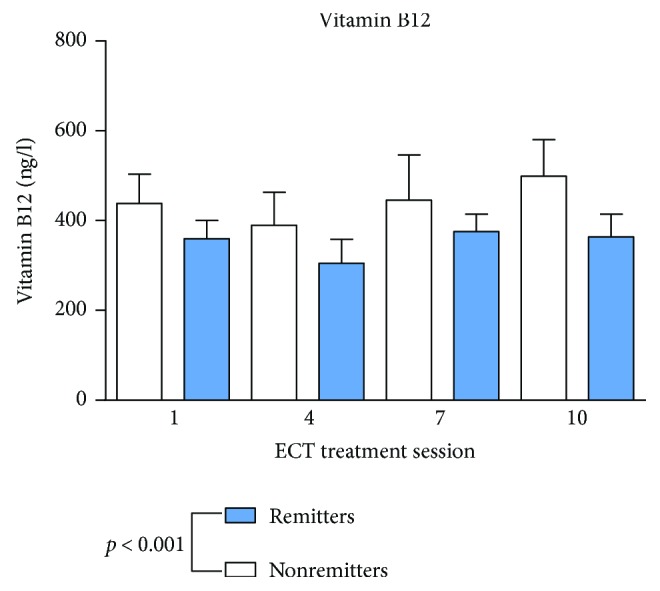
Vitamin B12 serum levels in remitters and nonremitters. Mixed linear modelling showed significantly lower levels of vitamin B12 in remitted patients. The p value given in the figure is derived from mixed linear modelling. Error bars show the standard error of the mean (SEM).